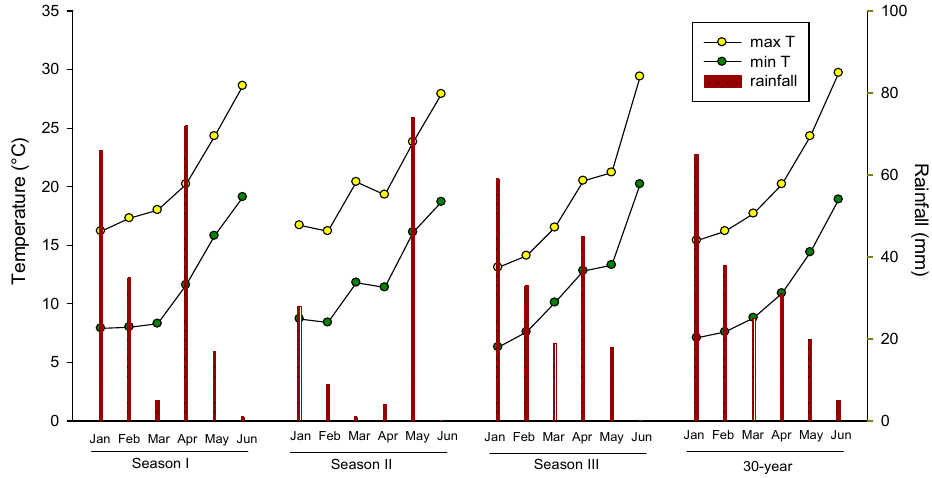
Figure 1. Average monthly maximum and minimum air temperatures and total monthly rainfall for the three seasons and 30-year period.